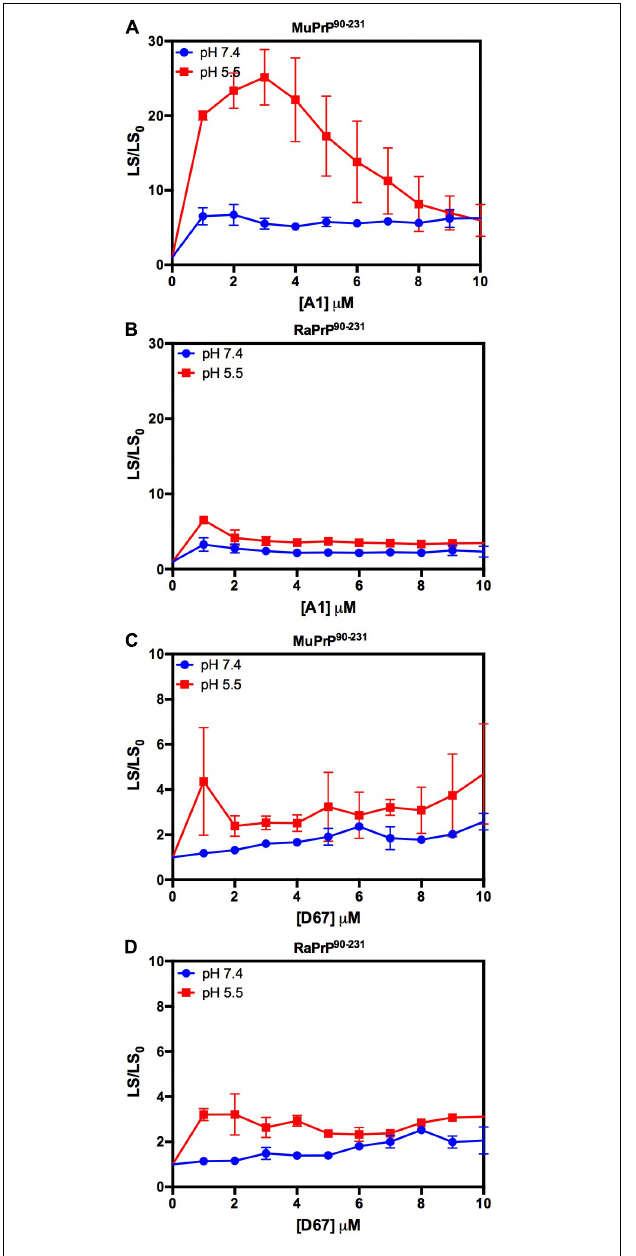
FIGURE 8 | RaPrP 90 − 231 aggregates less upon binding to DNA oligonucleotides. Effect of A1 (A,B) and D67 (C,D) on the relative light scattering of PrP 90 − 231 . Proteins used are MuPrP (A,C) and RaPrP (B,D) at pH 5.5 (red) and 7.4 (blue). The curves were performed with 5 µ M PrP 90 − 231 and increasing concentrations of oligonucleotides (from 1 to 10 µ M). The experiments were performed in 50 mM Tris buffer containing 100 mM NaCl at pH 7.4 or 20 mM sodium acetate buffer containing 100 mM NaCl at pH 5.5. All experiments were performed at 25 ◦ C. The error bars represent the standard deviation of at least two independent experiments.